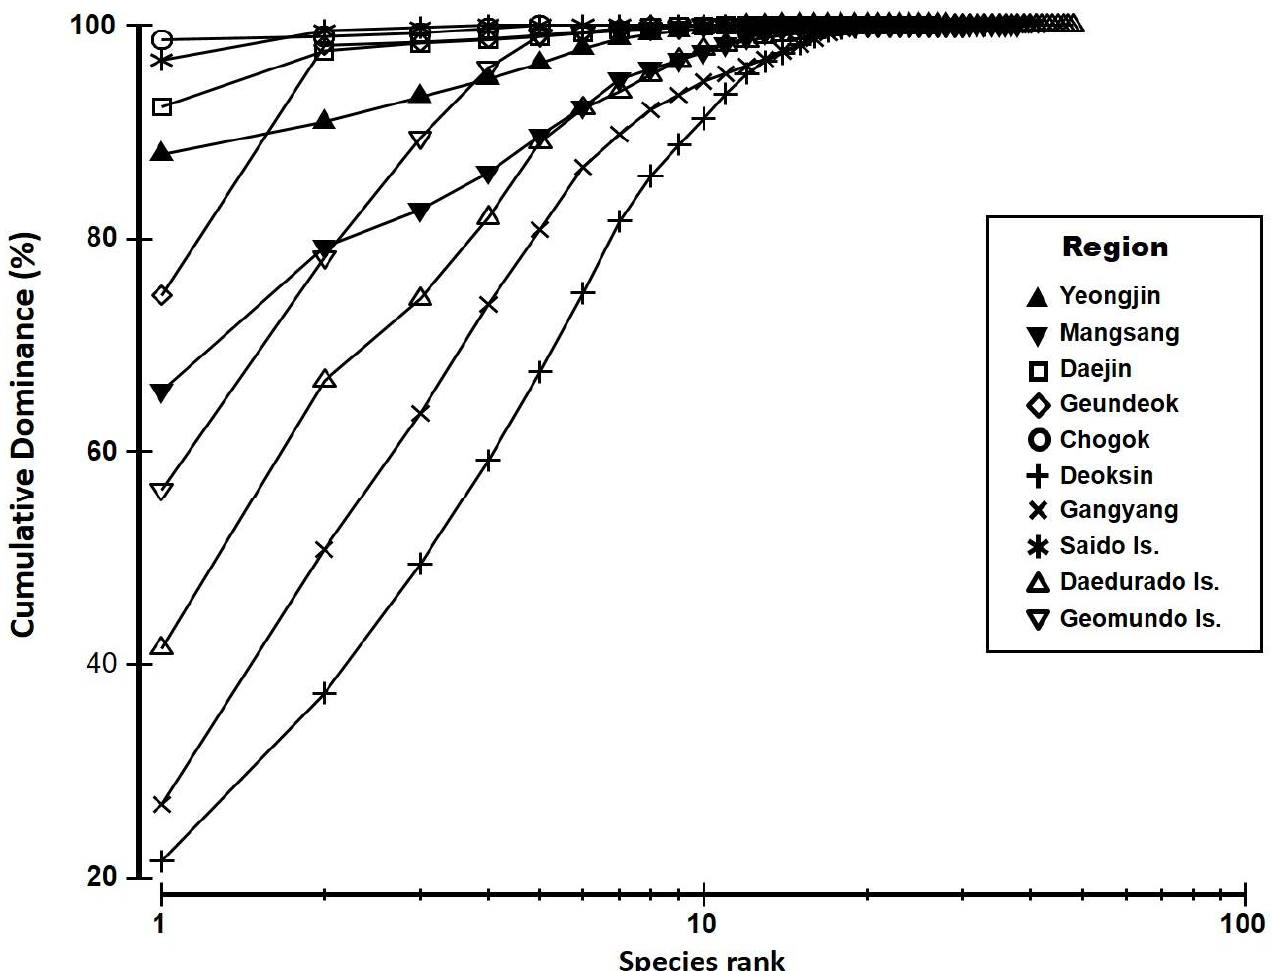
Figure 2. K-dominance curve of seaweed beds at the study